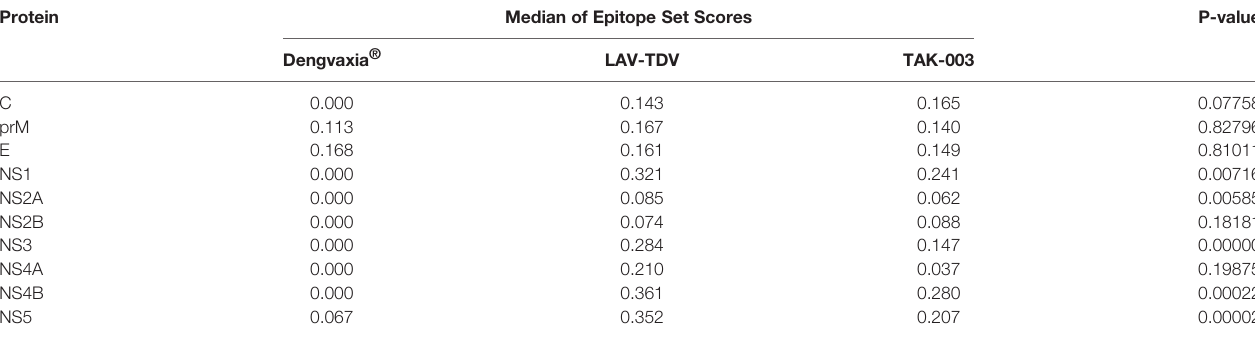
TABLE 2 | Results of the medians of the epitope set scores and the p-values derived from comparative analyzes between vaccines. Protein Median of Epitope Set Scores P-value